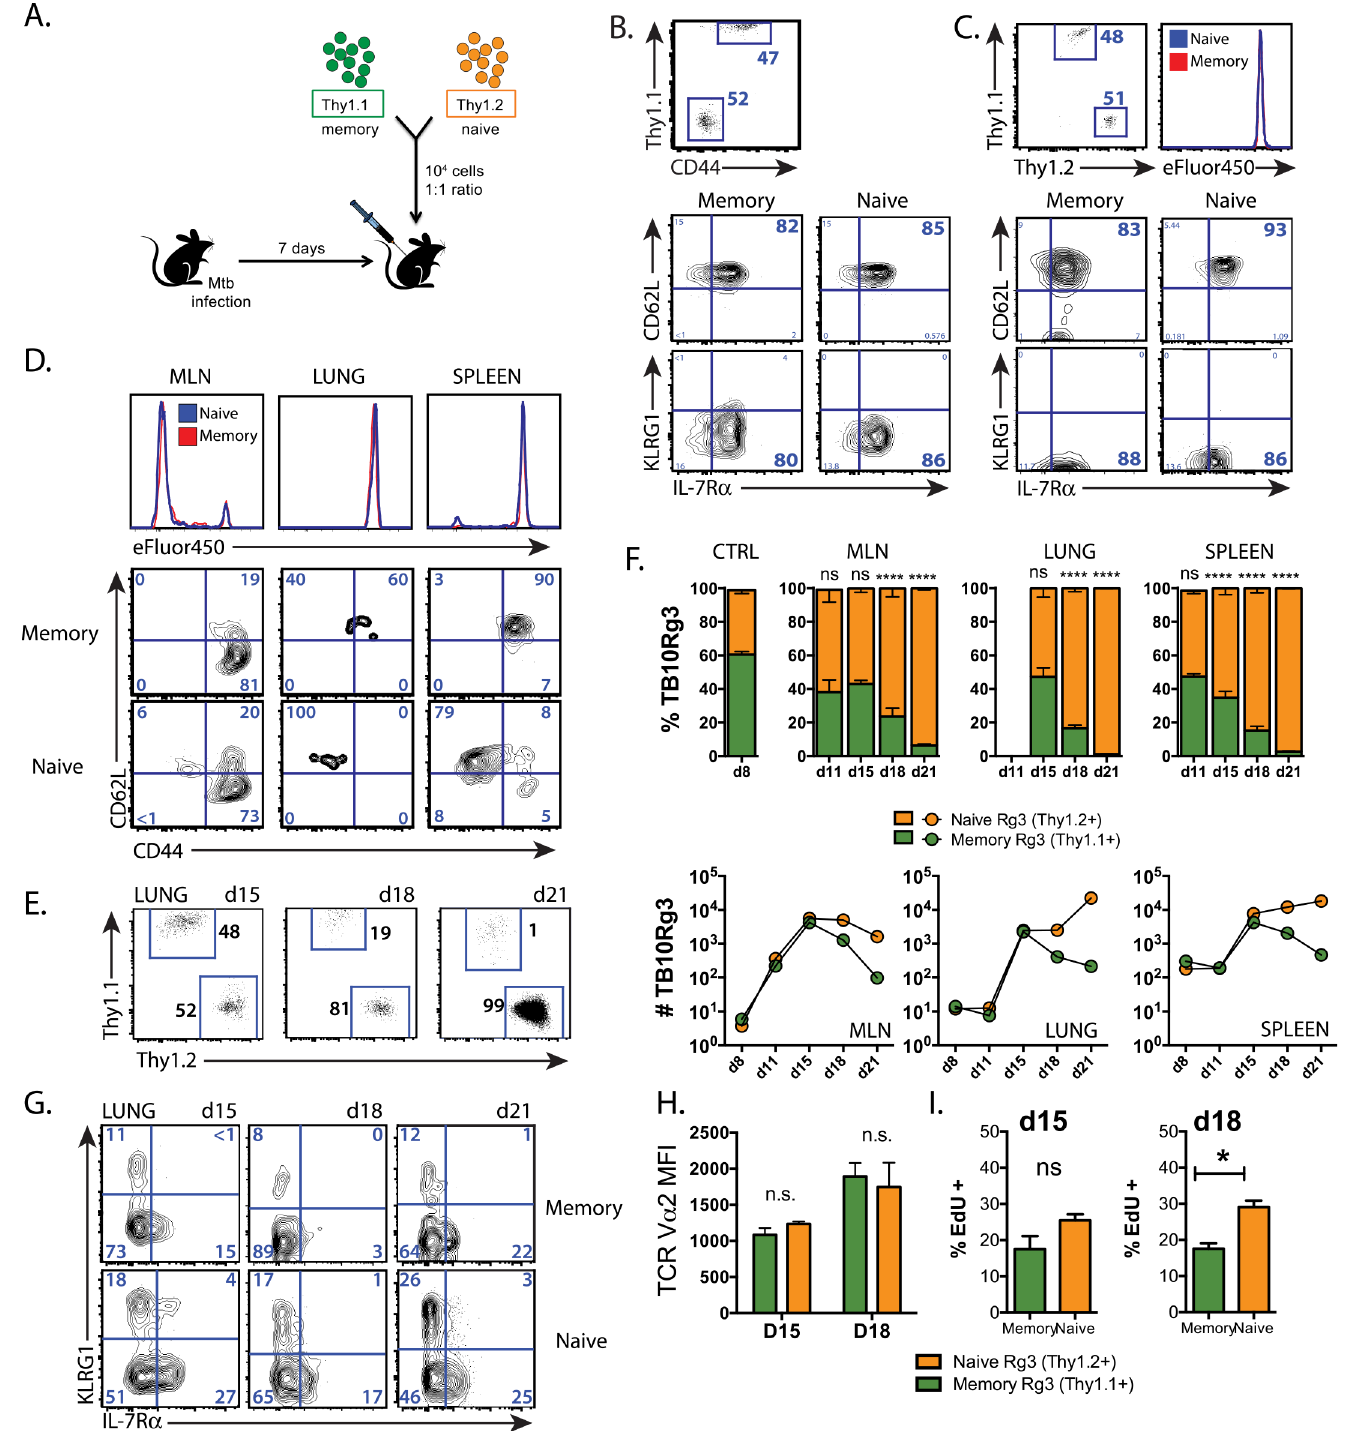
Fig 4. The primary response dominates the memory-derived secondary response during Mtb infection. (a) Experimental strategy for adoptive co- transfer experiments. Relative proportion of na ï ve and memory TB10Rg3 CD8 + T cells and their expression of CD62L, KLRG1, and IL-7R before transfer (b) and in the spleen 1d after transfer into uninfected mice (c) . Baseline labeling with the eFluor450 proliferation dye is shown. (d) Concatenated histograms of eFluor450 staining of na ï ve and memory-derived TB10Rg3 cells in the MLN, lung, and spleen (top) and their CD62L and CD44 expression (bottom) from a representative experiment on d11 post-infection. (e) Proportion of adoptively-transferred memory (Thy1.1 + ) and na ï ve (Thy1.2 + )-derived TB10Rg3 CD8 + T cells in the lung 15, 18, or 21d after Mtb infection. (f) The relative proportion of memory (Thy1.1) and na ï ve (Thy1.2)-derived TB10Rg3 CD8 + T cells in the